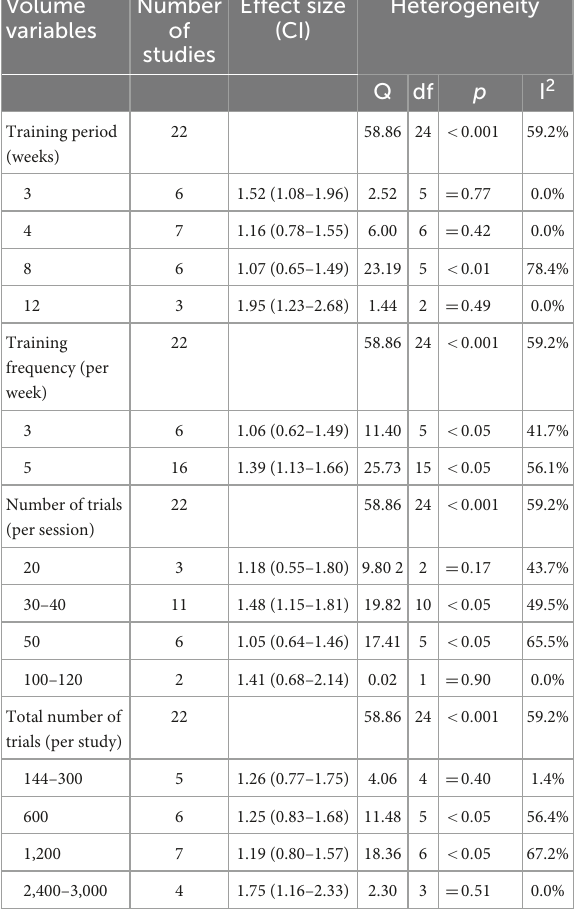
TABLE 2 Training volume variables with the effect size (ES): Motor imagery training* vs. no-exercise control. Volume